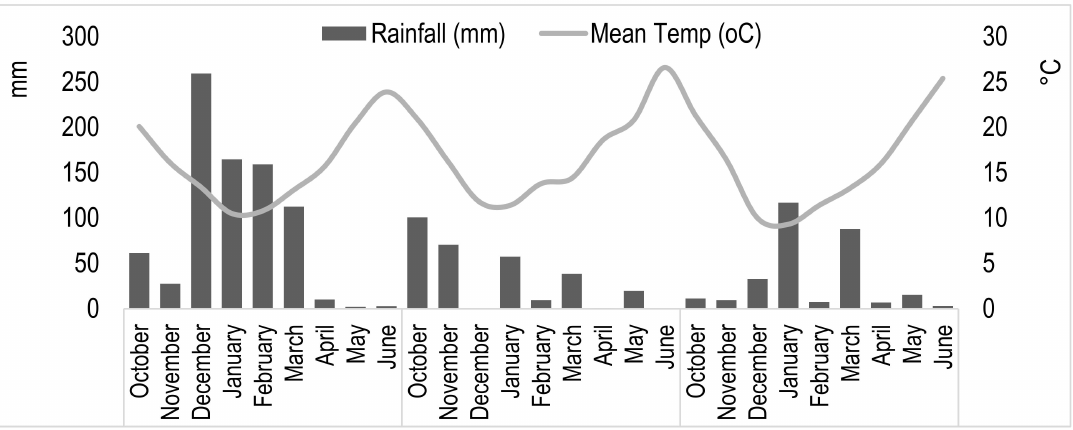
Figure 1. Precipitation and air temperature in the three growing seasons/harvest years (2014/2015, 2015/2016 and